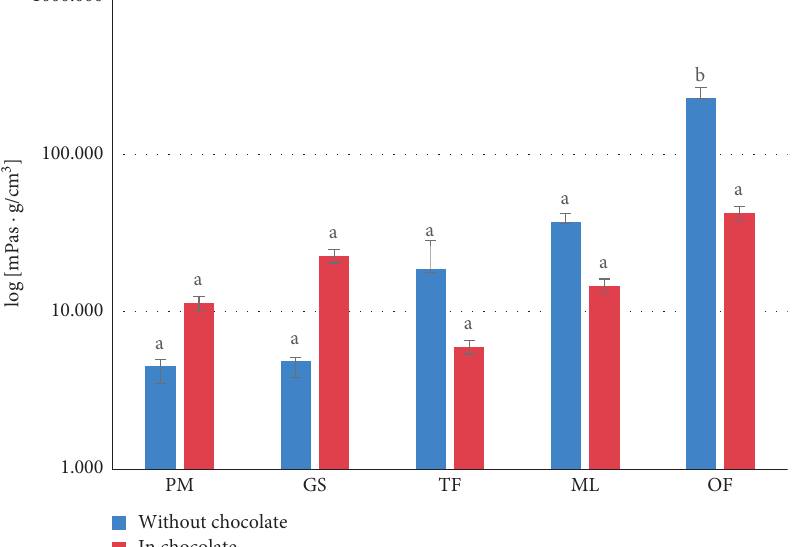
Figure 2: Ultrasonic viscosity measurement results (mPas g/cm 3 ) of tested high-protein bars without chocolate covering and with chocolate covering. Letters (a-b) indicate significant differences at P < 0.05 (Tukey’s HSD test). OF oligofructose, TF—tapioca liquid fiber, ML—maltitol, PM—chickpea-maize liquid